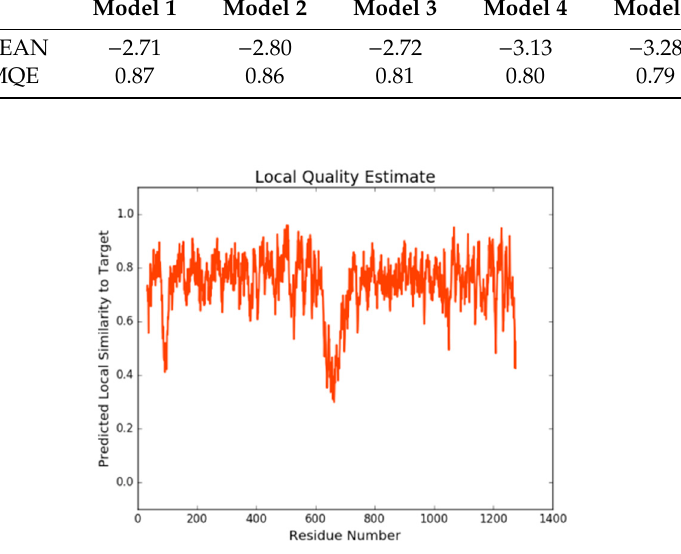
Figure 2. Local quality plot of the Model 1, generated by the SWISS-MODEL tool.